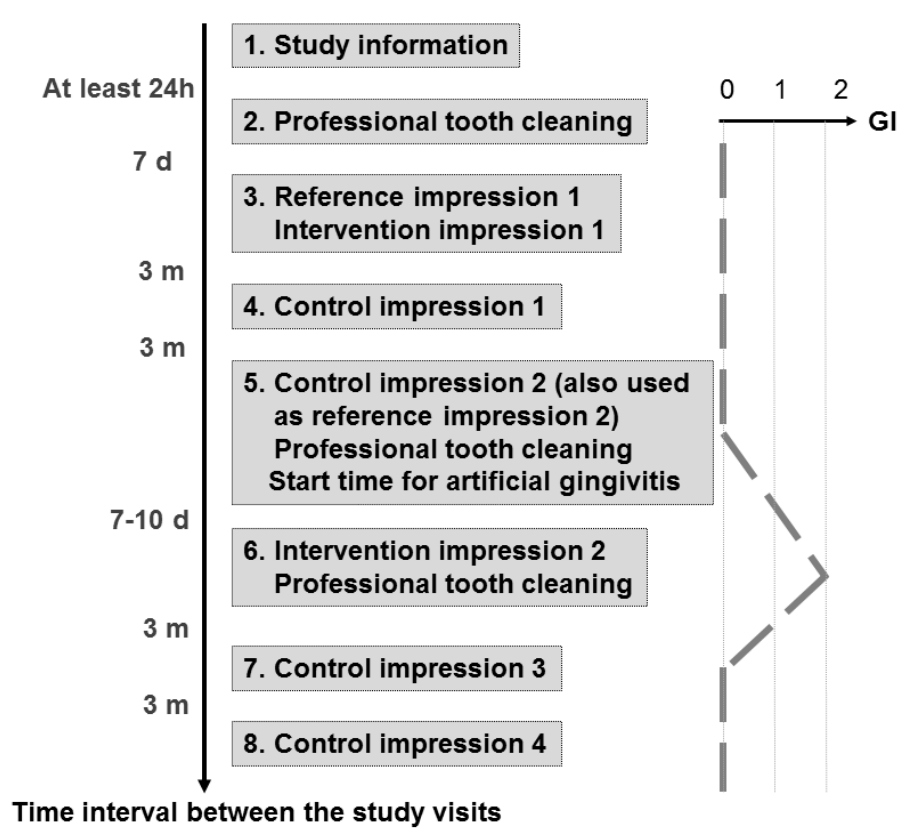
Figure 2. Study procedure in eight study visits with intended course of the gingival index (GI); h: hours; d: days; m: months.